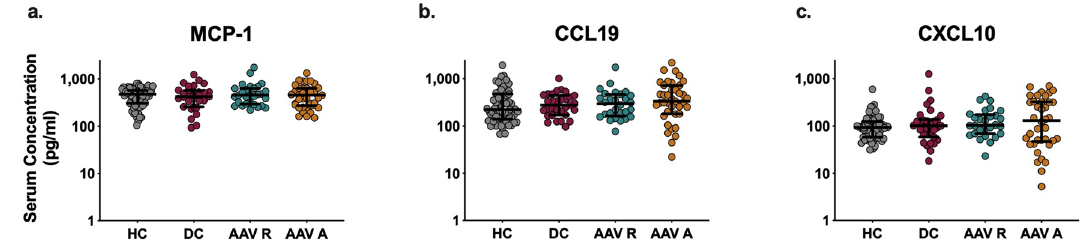
Figure 2. Serum concentrations of Type 1 IFN regulated chemokines expression In AAV patients and controls. Serum samples were obtained from HC (n = 67), DC (n = 31), AAV R patients (n = 29) and AAV A patients (n = 41). The concentration of circulating ( a ) MCP-1, ( b ) CCL19 and ( c ) CXCL10 were measured using ELISAs. Whole horizontal lines represent the median and IQR of each cohort. Statistical analysis was performed using One-Way ANOVA with Dunn’s multiple comparison testing. No statistical differences were